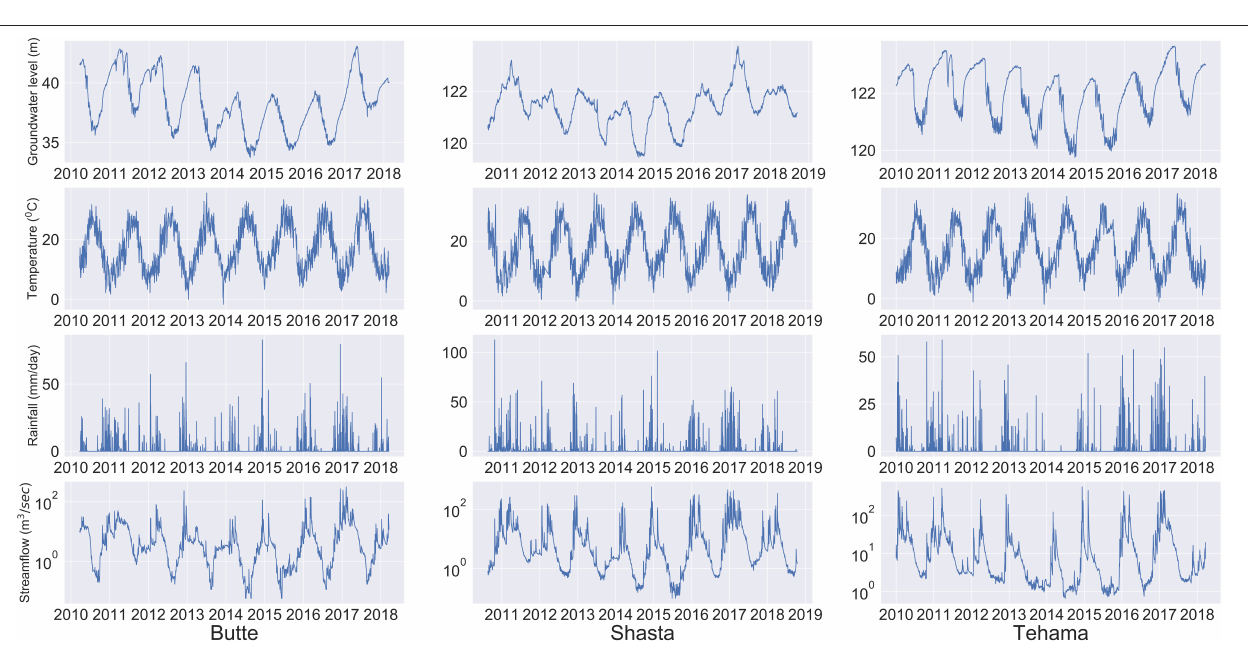
FIGURE 2 | Timeseries of all features at the three well sites at a daily frequency from 2010 to 2018. The top panel at each site shows the groundwater level (meters above mean sea level). The second panel shows the temperature ( ◦ C), the third panel shows the precipitation (mm), and the bottom panel of sites shows the river flow (m3 /